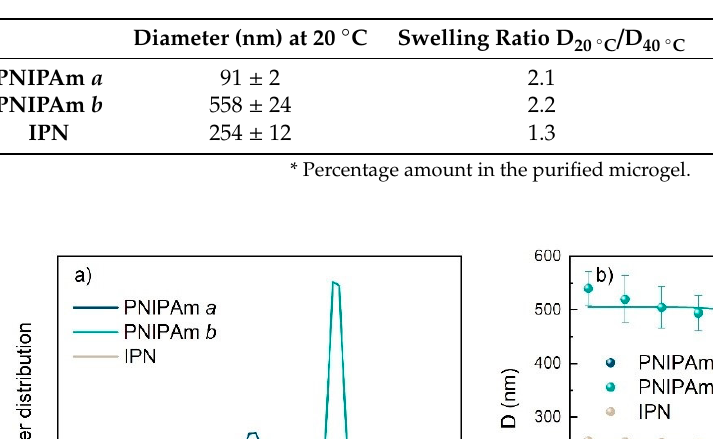
Table 1. Microgels physical-chemical characteristics